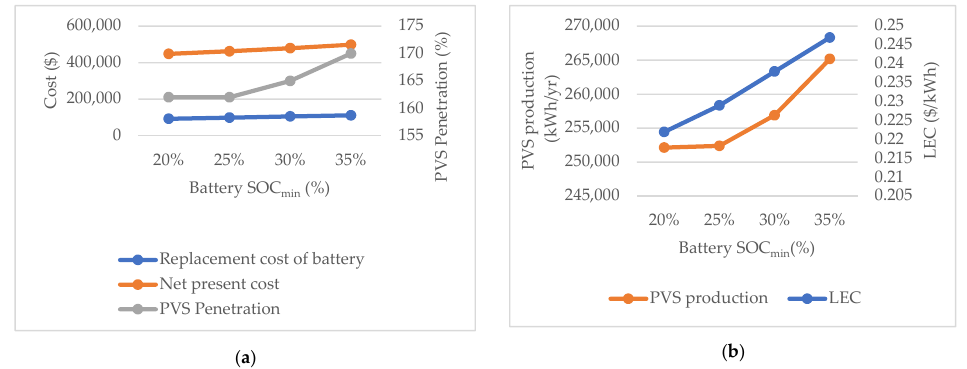
Figure 19. Effect of rising battery SOC min ( a ) effect of SOC min on replacement cost of battery, net present cost and PVS penetration; ( b ) effect of SOC min on PVS production and levelized energy cost.